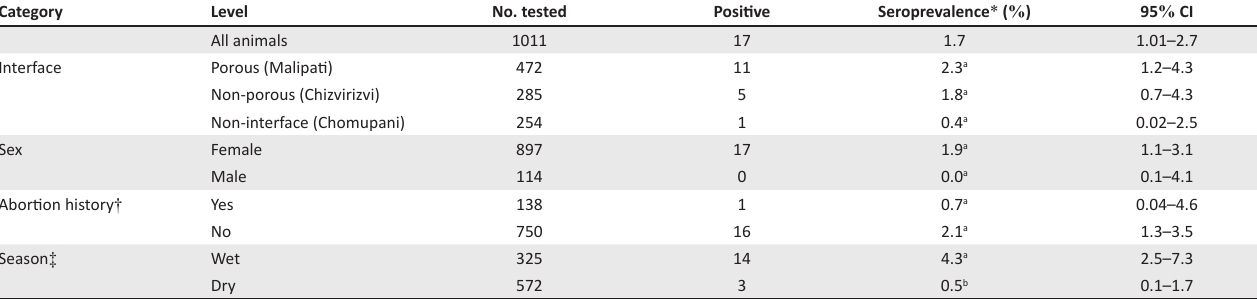
TABLE 1: Distribution of Rift Valley fever seroprevalence in cattle according to different categories.